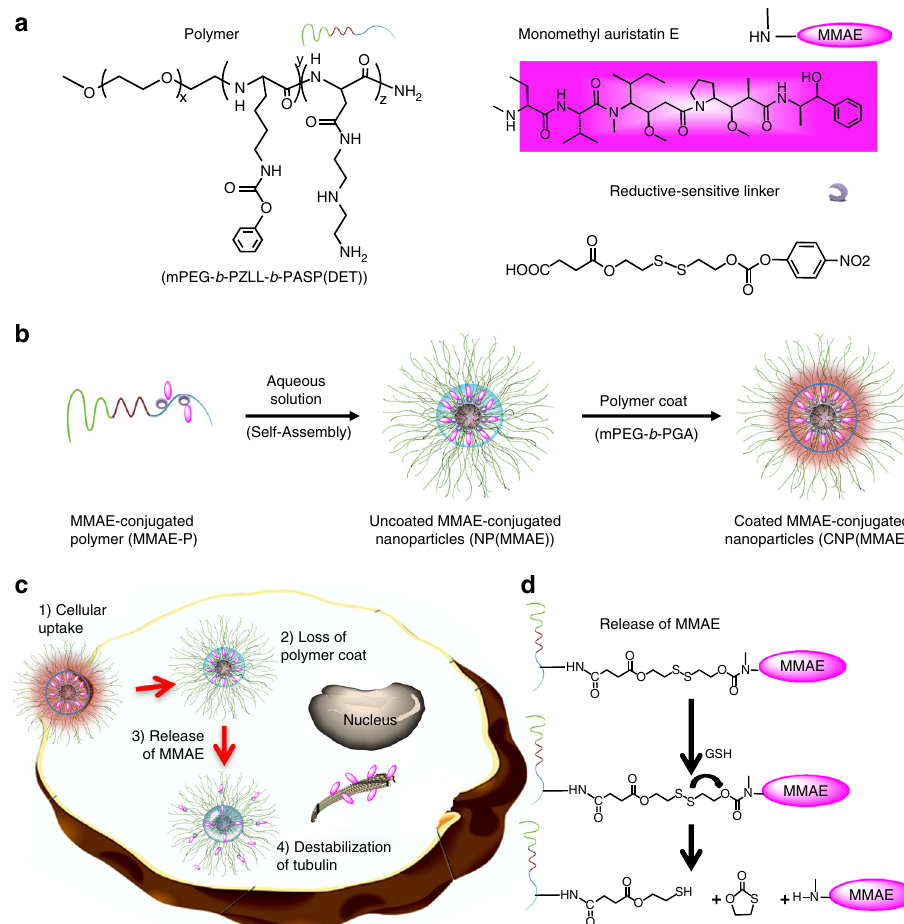
Fig. 1 MMAE-conjugated nanoparticles enable intracellular release within cancer cells. a Structures of the biodegradable and cationically-charged polymer of methoxy-poly(ethylene glycol)- block -poly(carbobenzyloxy-L-lysine)- block -poly{N-[N-(2-aminoethyl)-2-aminoethyl]aspartamide} (mPEG- b -PZLL- b- PASP (DET)), the highly potent microtubule inhibitor monomethyl auristatin E (MMAE), and a reductive-sensitive linker. b Aqueous dissolution of MMAE- conjugated polymer (MMAE-P) leads to the spontaneous self-assembly of MMAE-conjugated nanoparticles (NP(MMAE)); further complexation of the water-soluble and polyanionic diblock copolymer of methoxy-poly(ethylene glycol)- block -poly(glutamic acid) (mPEG- b -PGA) aids to stabilize these coated nanoparticles (CNP(MMAE)). c Intracellular uptake and release of MMAE from CNP(MMAE). d Mechanism of the release of free MMAE from MMAE-P, which is driven by high intracellular concentrations of reducing agents such as glutathione (GSH; 5mM intracellular vs. 25 – 50 µ M in the extracellular